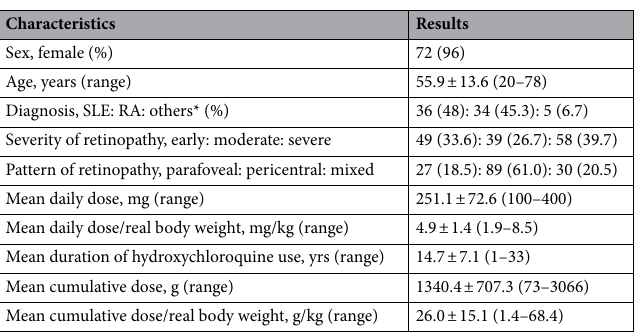
Table 1. Demographic data and clinical characteristics of the 75 patients included in this study. RA rheumatoid arthritis, SLE systemic lupus erythematosus. *Other medical indications included mixed connective tissue disease and Sjögren